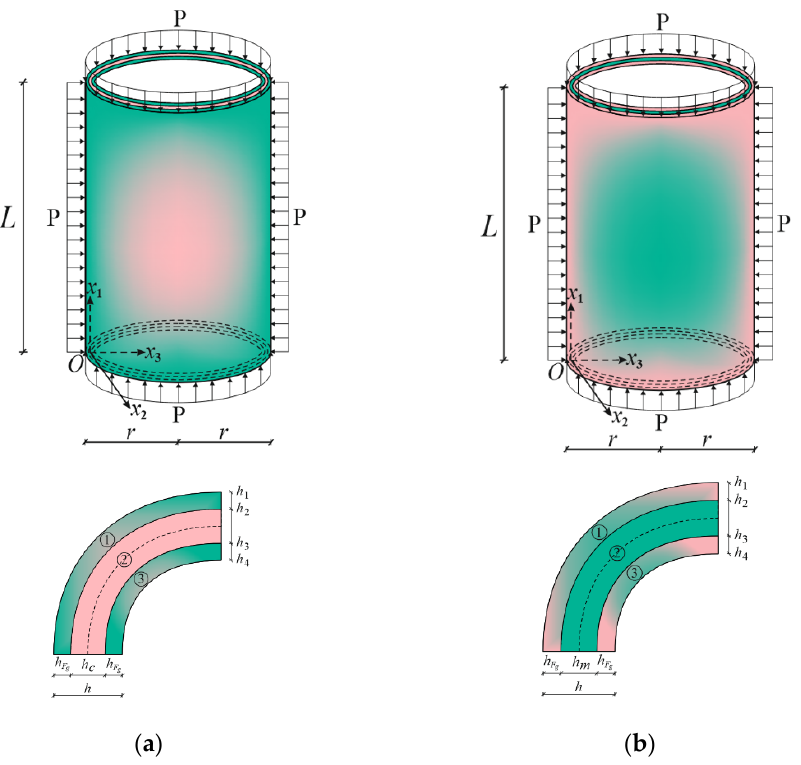
Figure 1. ( a ) FG 1 /C/FG 1 and ( b ) FG 2 /M/FG 2 sandwich cylindrical shells under hydrostatic pressure and their cross sections.